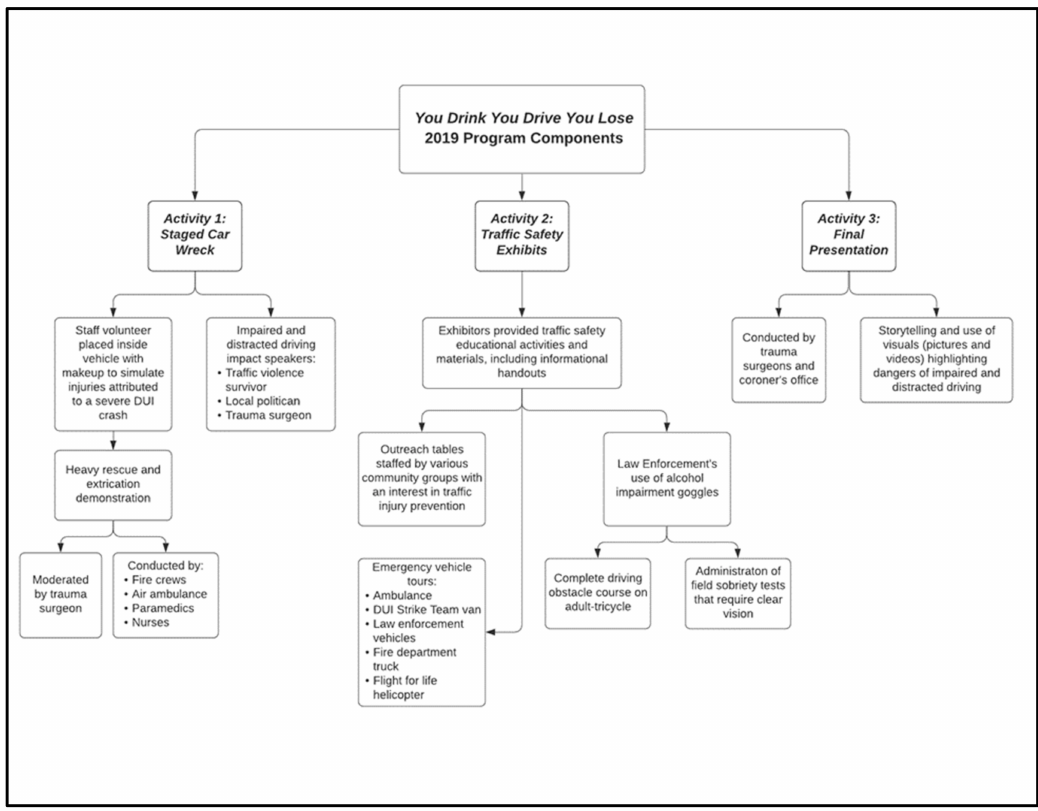
Figure 1. You Drink, You Drive, You Lose (YDYDYL) 2019 Program